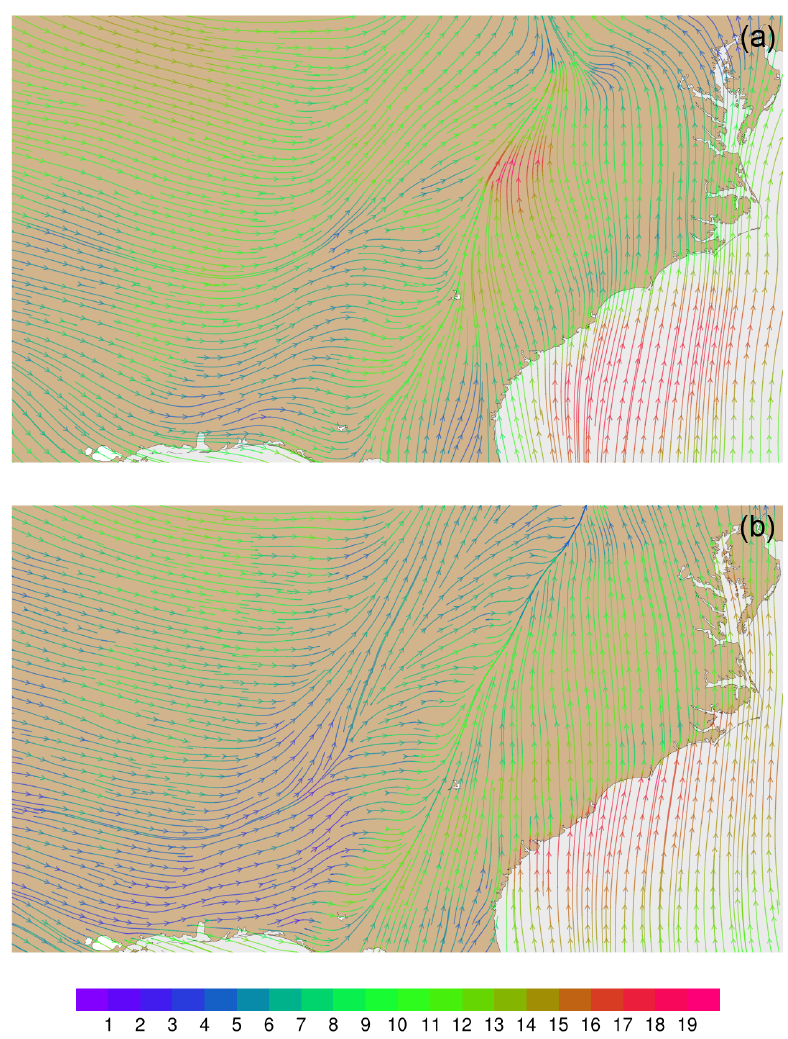
Figure 11. Streamline analysis for layer 1 (surface) at 00:00UTC on 31 January 2013 focused on the southeastern United States (a) from MPAS-A using FDDA and (b) FDDA target field. Streamline color indicates wind speed (ms − 1 )